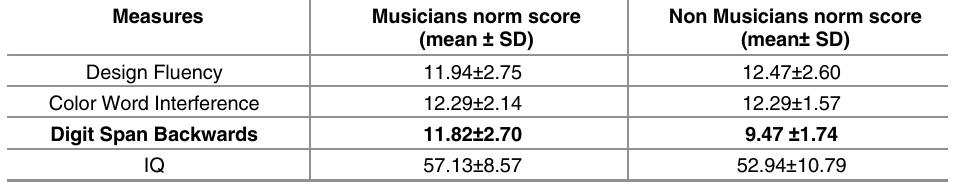
Table 2. Group characteristics of musicians and non-musicians for cognitive tasks. Statistically signifi- cant group differences are highlighted in bold ( p < 0.01).